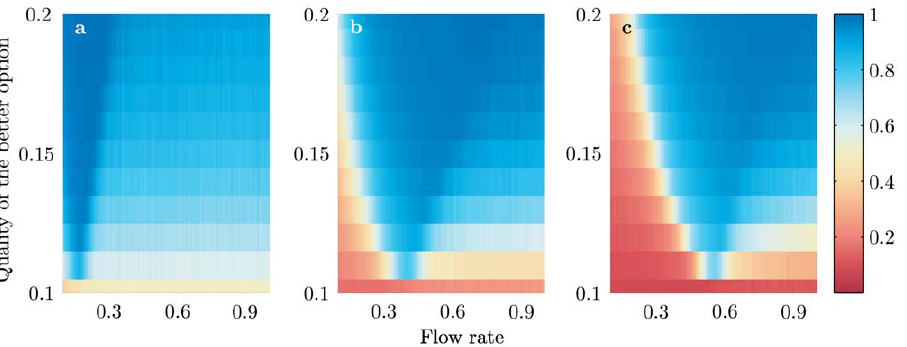
Figure 4. Decision quality as a function of the flow rate of individuals w and of the quality of the better option 1 ( i = 1 ~ 1 ) as obtained by Monte Carlo simulations. (a) case n ~ 2 , (b) n ~ 4 and (c) n ~ 8 . Other parameter values as in Fig. 1, number of realizations is 5000.